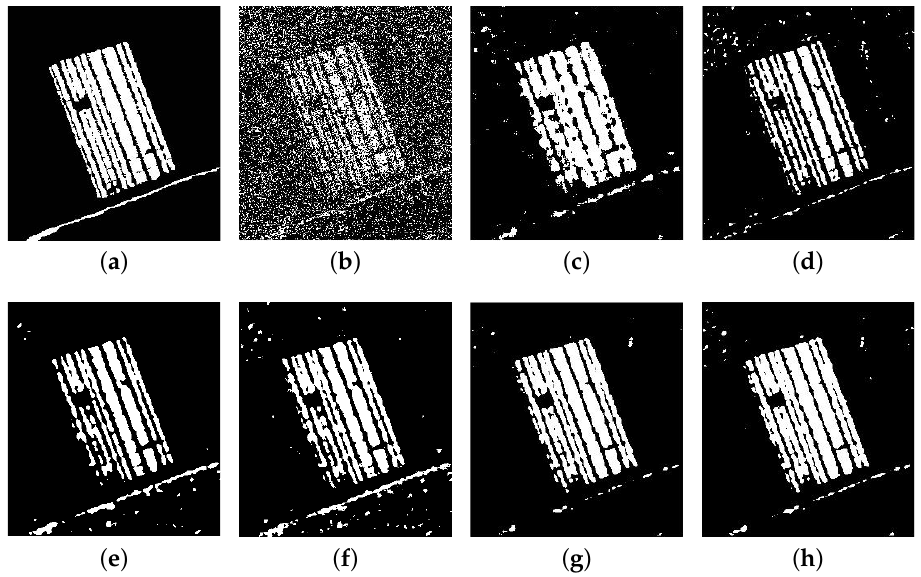
Figure 13. Change detection results of the Farmland D data set: ( a ) Reference. ( b ) FCM. ( c ) NLMFCM.